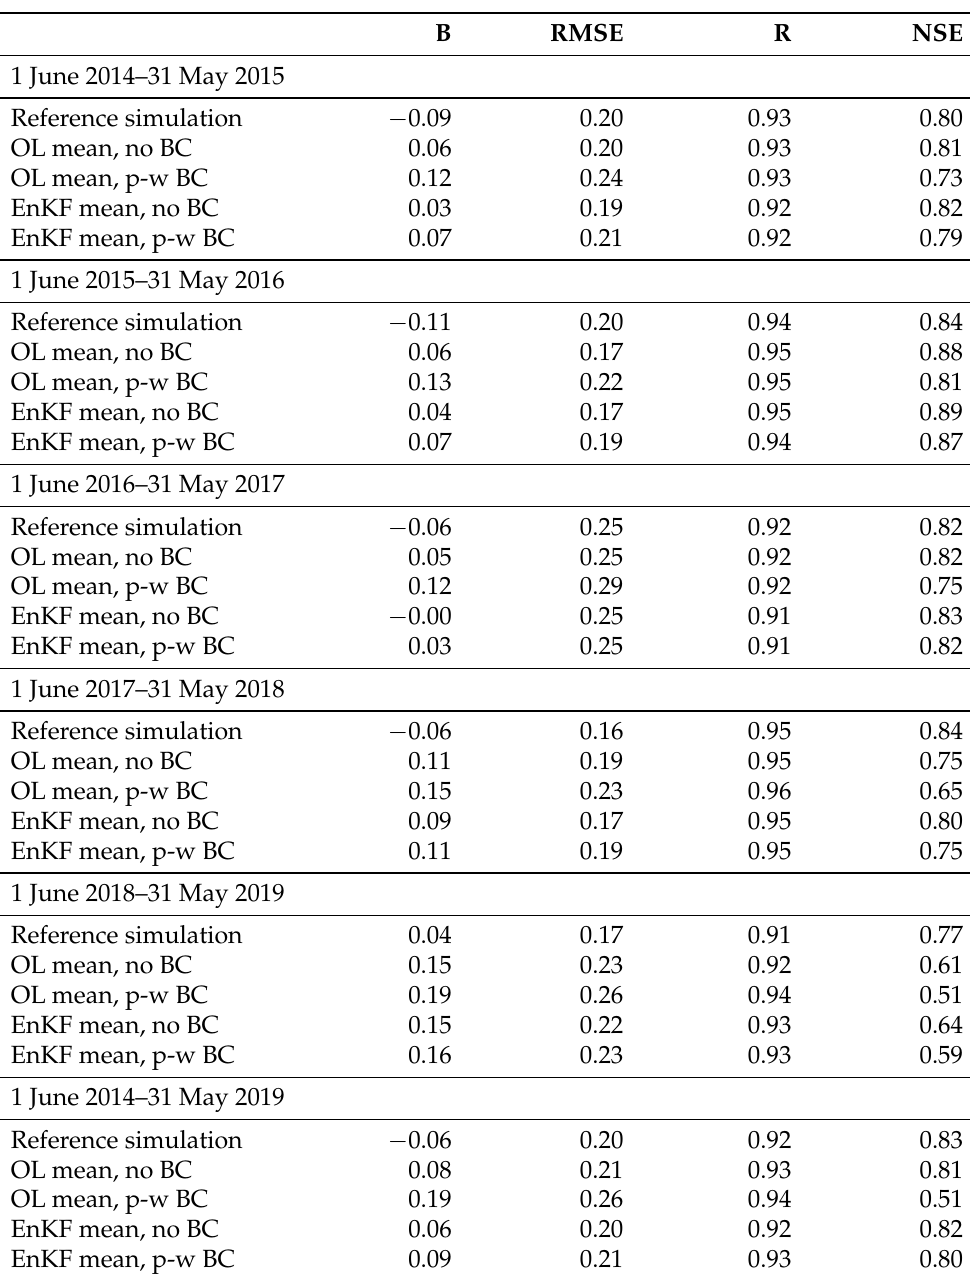
Table 4. Synoptic statistics for streamflow, Demer catchment. The unit for bias and RMSE is mm/day and the scores are calculated with respect to the streamflow observations